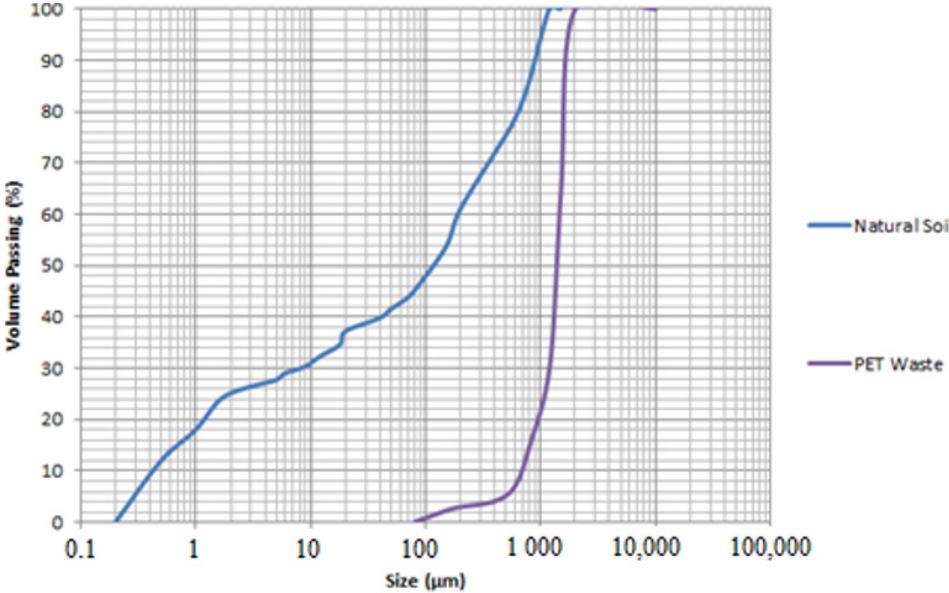
Figure 3. Natural soil and PET waste granulometric analysis.